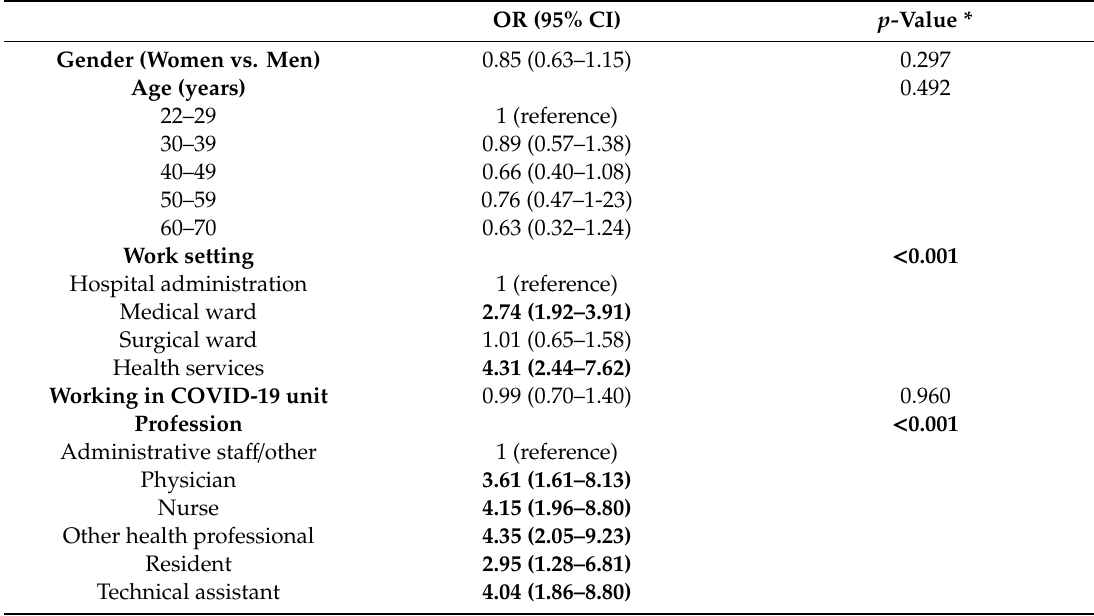
Table 4. Risk of COVID-19 infection in 5942 workers of Verona University Hospital, as a function of main demographic and occupational characteristics. Odds ratio (OR) with the corresponding 95% confidence intervals (95% CI) and p values were derived by a multivariable logistic